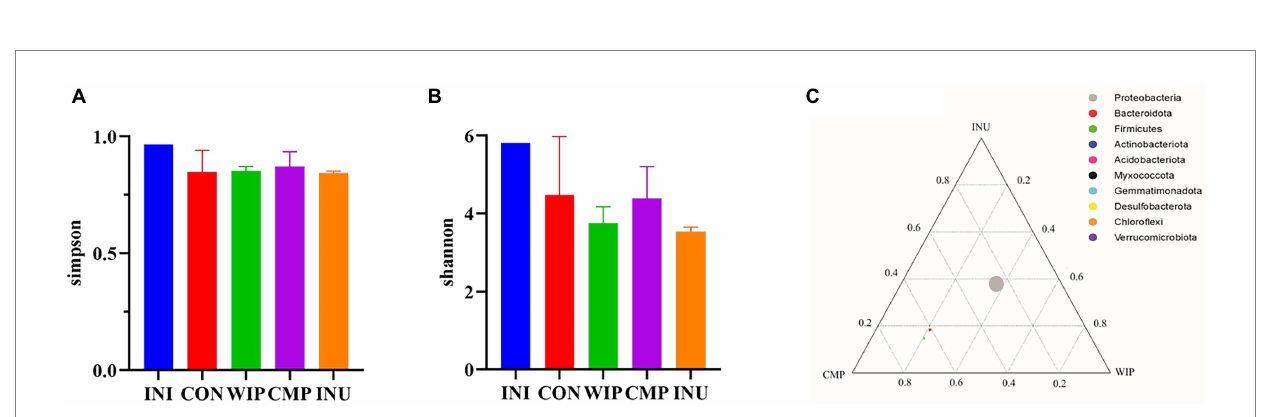
FIGURE 9 Diversity and evenness analysis of gut microbial communities. (A) Simpson index, (B) Shannon index, and (C) ternary plot in WIP, CMP, and INU.